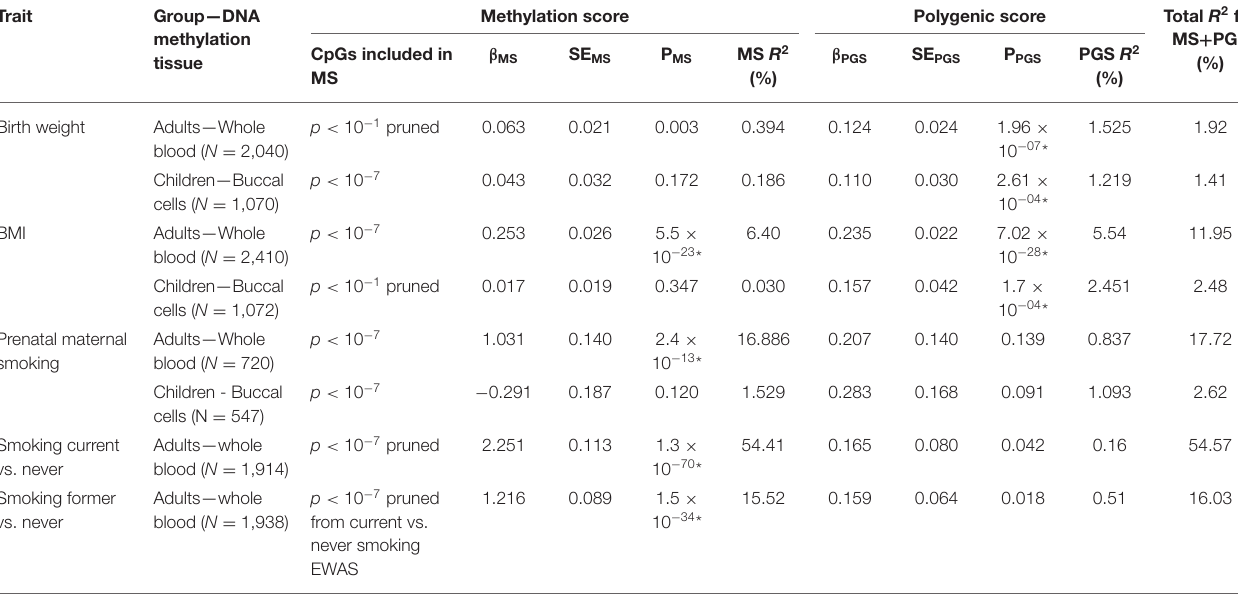
TABLE 5 | Results of the multi-omics prediction of birth weight, BMI, prenatal maternal smoking, and current and former smoking. Trait Group—DNA methylation